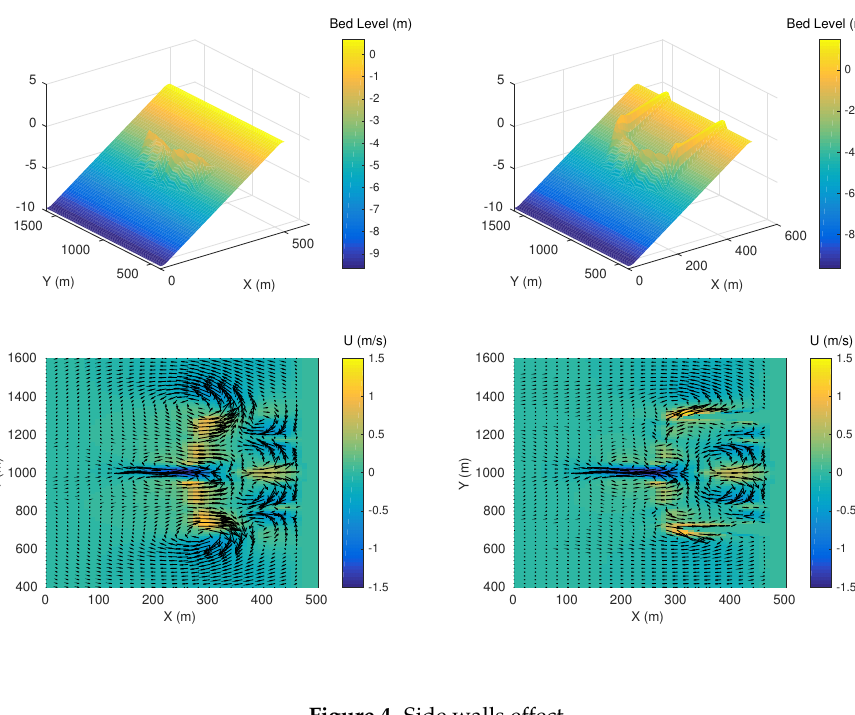
Figure 4. Side walls effect.